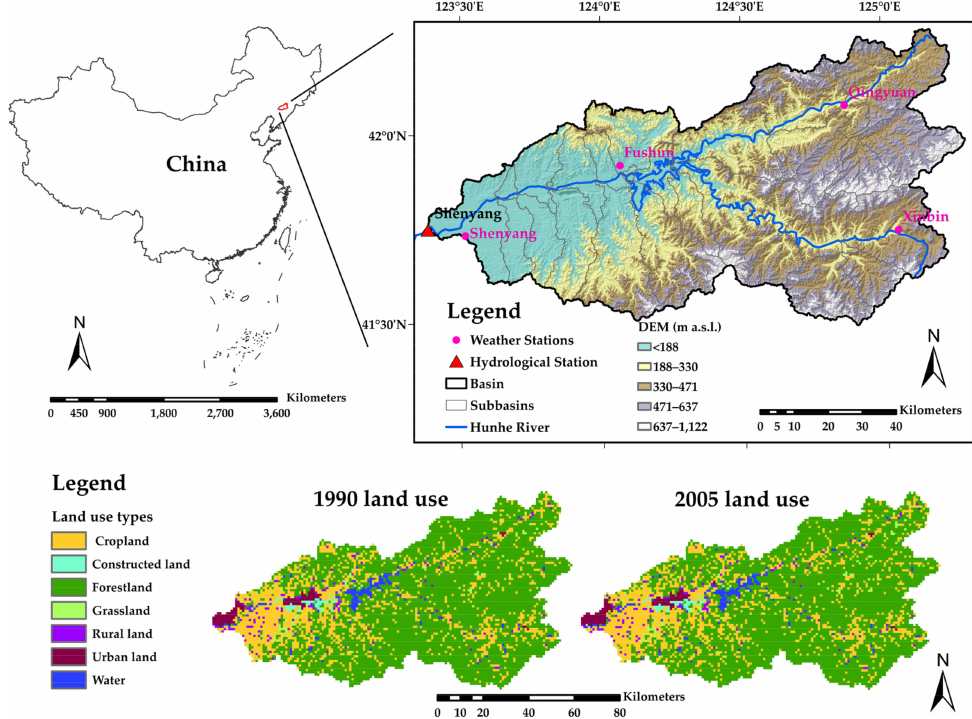
Figure 1. Overview of the study area and two land use maps in different